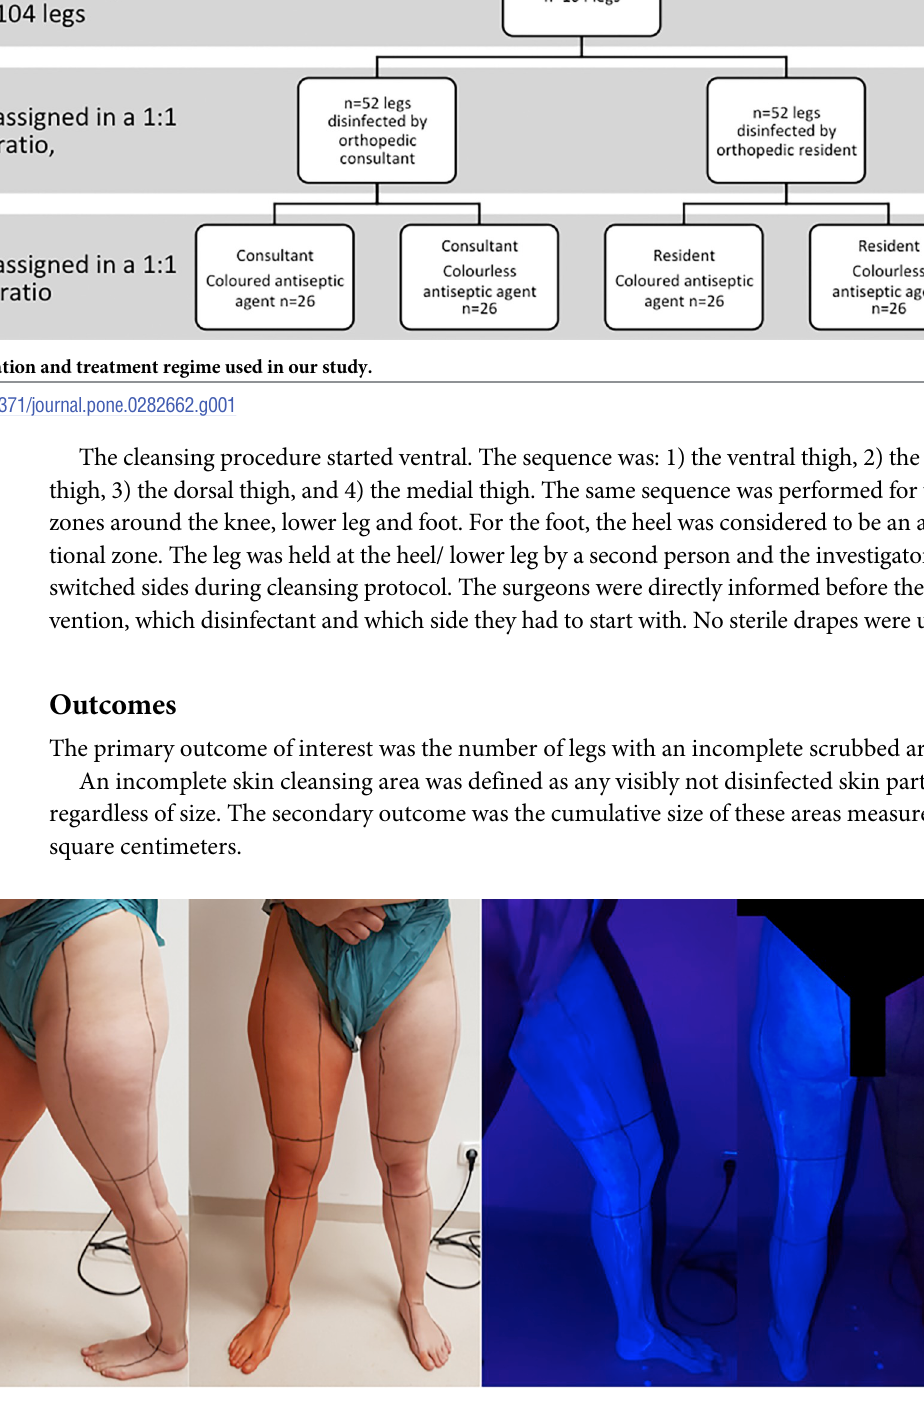
Fig 2. The leg was divided into 17 zones as demonstrated on the two images to the left: 1) thigh ventral, 2) thigh lateral, 3) thigh dorsal, 4) thigh medial, 5) knee ventral, 6) knee lateral, 7) knee dorsal, 8) knee medial, 9) lower leg ventral, 10) lower leg lateral, 11) lower leg dorsal, 12) lower leg medial, 13) foot ventral, 14) foot lateral, 15) foot plantar, 16) foot medial, 17) heel. The two images on the right show the appearance of the skin preparation under the UV light.